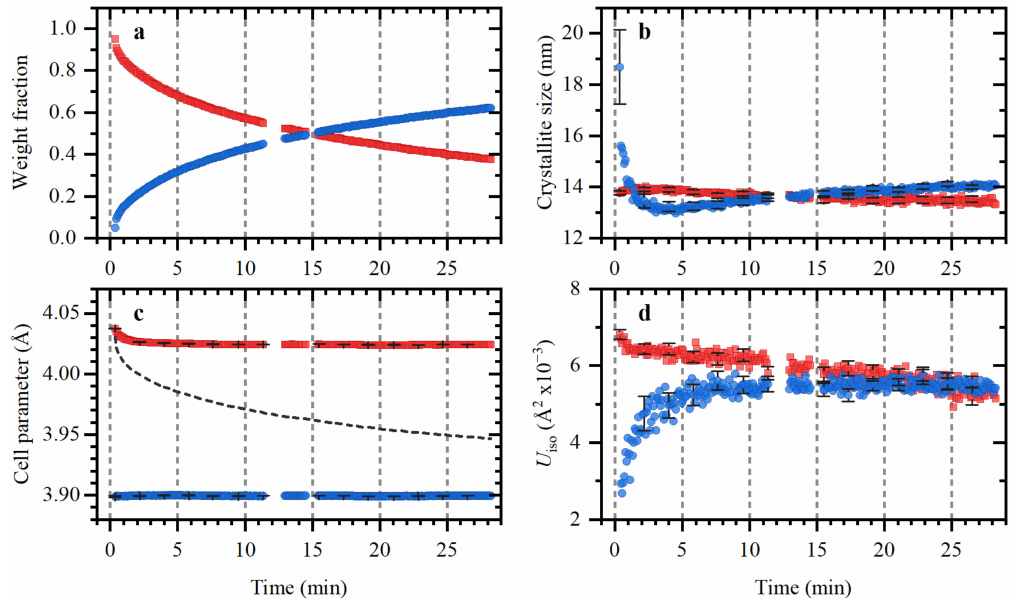
Figure 5. Fractions ( a ), crystallite sizes ( b ), cell parameters ( c ) and U iso values ( d ) for α - (blue circles) and β - (red squares) hydride phases of palladium as function of time after fast outgassing from 2.1 bar hydrogen to vacuum at 80 ◦ C obtained by Rietveld refinement of XRPD